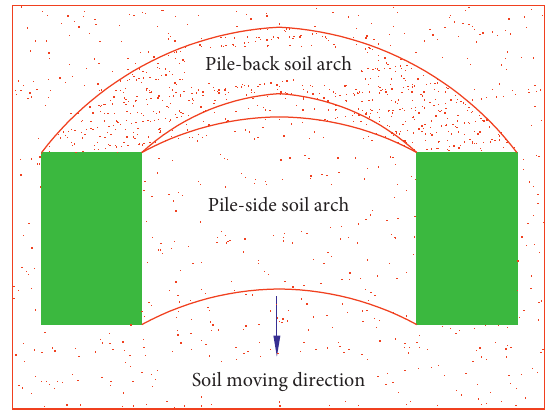
Figure 1: Soil arch plane